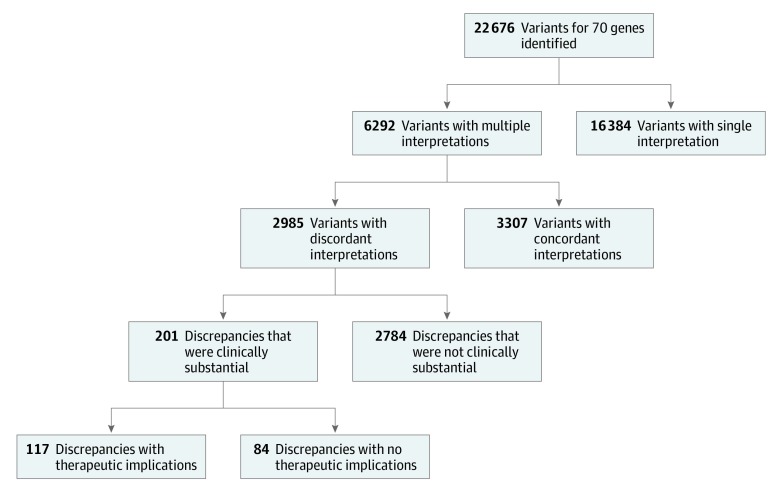
Study Flowchart